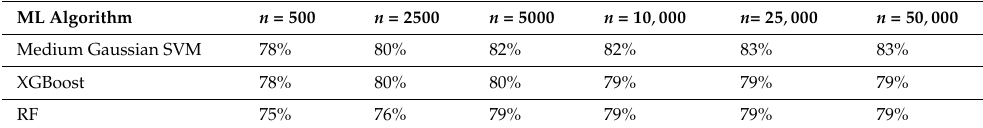
Table 7. Example of the impact of the number of training samples on the LOS detection accuracy ([%]) with simulated data; TDL channels; PRS signals; variable SNR between − 20 dB and 0